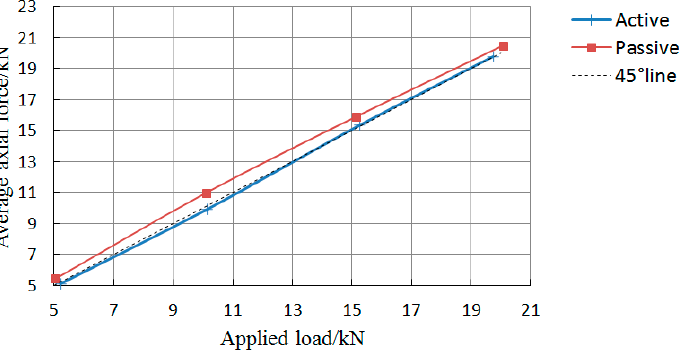
Figure 17. The relationship between the average value of the bolt-shaft and the applied load.